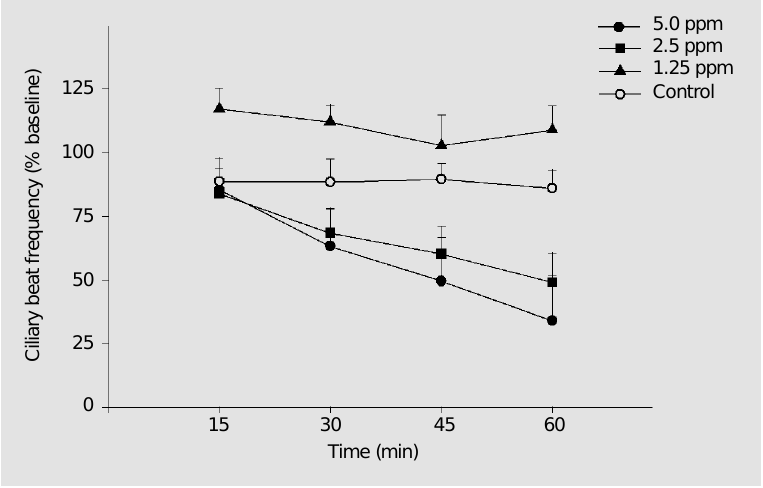
Figure 2 - Mean (± SEM) values of relative change in frog palate ciliary beat frequency (CBF) measured after immersion in Ringer or different concentrations of formaldehyde. The relative changes were obtained by dividing all observations of each assay by the corre- sponding baseline value. CBF decreased significantly in the presence of 2.5 and 5.0 ppm of formaldehyde compared to 1.25 ppm at 60 min